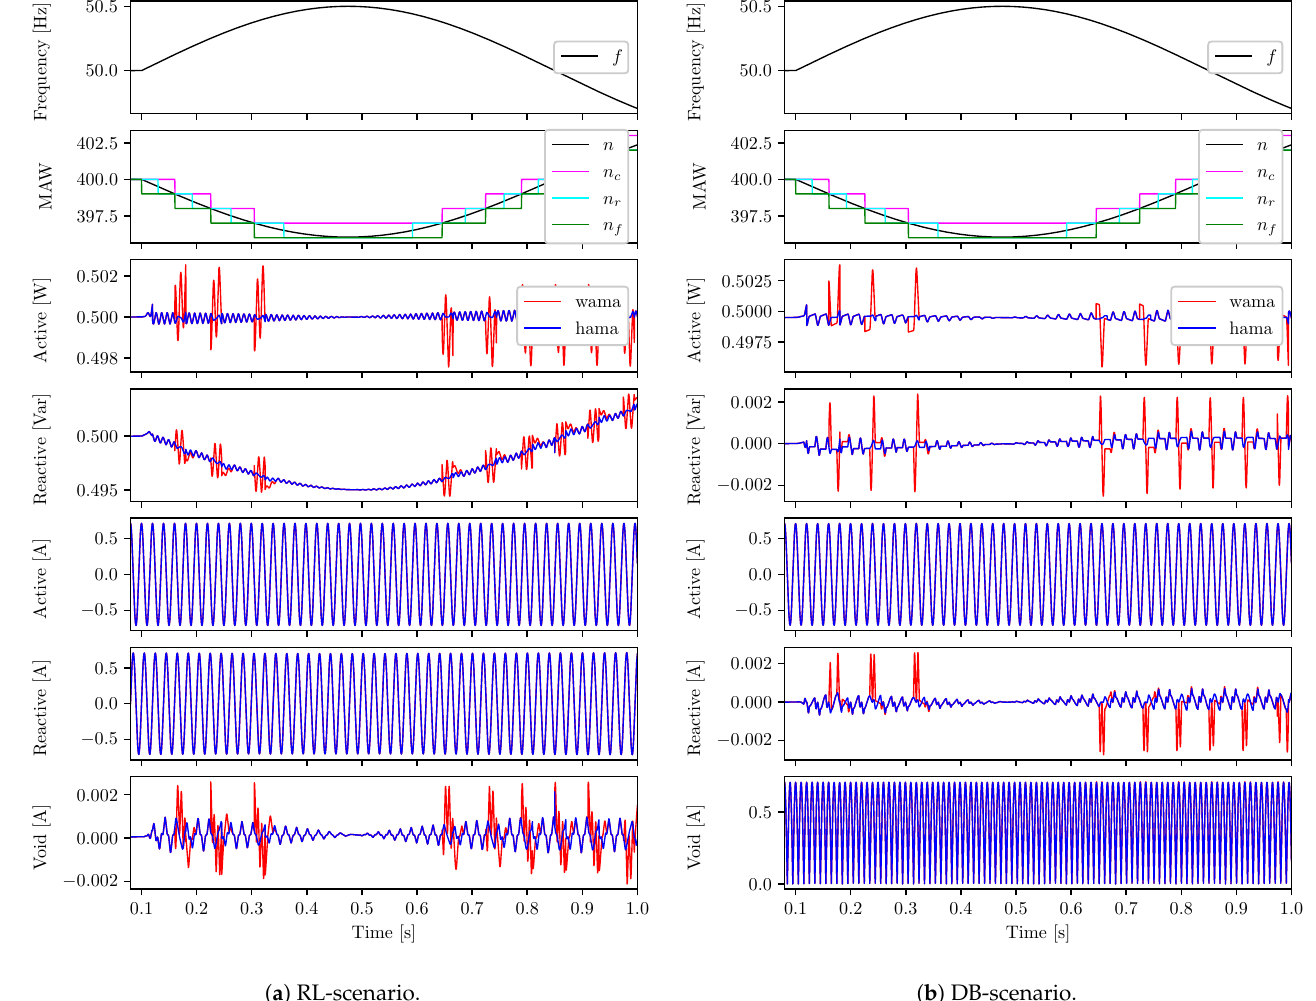
Figure 10. WAMA in red versus HAMA in